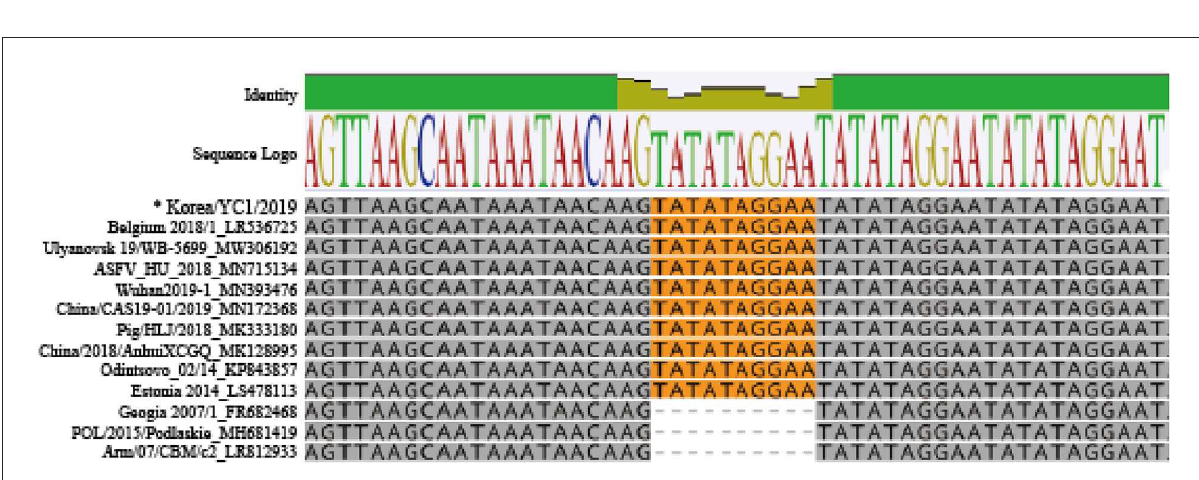
FIGURE5 Sequence alignment of intergenic region between I73R and I329L in ASFV genotype II and Korea/YC1/2019. Orange shading on the sequences indicates the 10-nucleotide tandem repeat sequence (TRS) insertion.